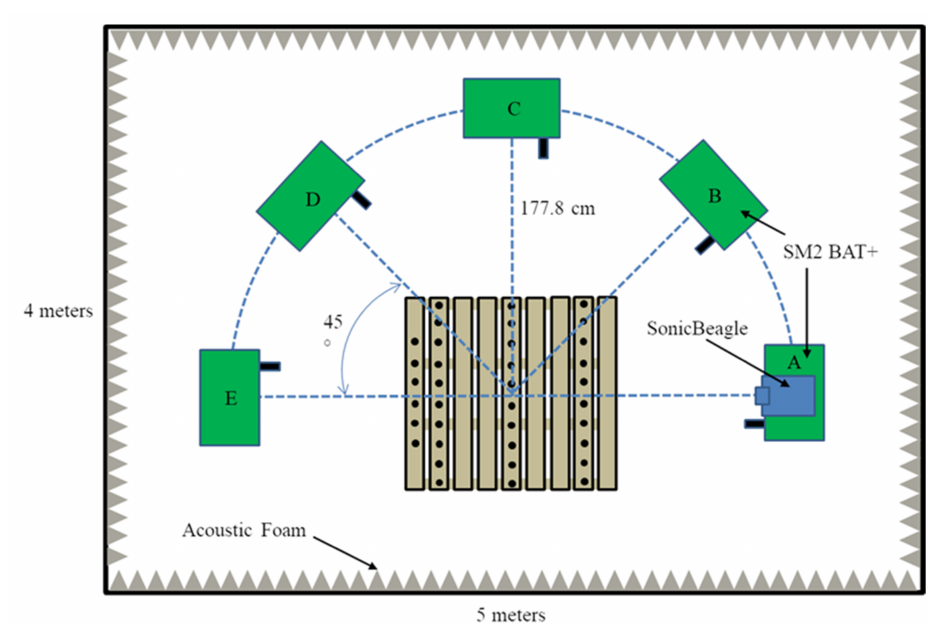
Figure 1. Diagram of the experimental setup in the anechoic chamber (4 m wide by 5 m long by 3 m high) where five SM2 BAT+ acoustic recorders (green rectangles) with SMX-U1 ultrasonic microphones (black rectangles; Wildlife Acoustics, Maynard, MA, USA) were arranged in a semicircle with radius 177.8 cm around a 107 cm × 121.9 cm wood pallet base with holes and mounting brackets designed to hold combinations of wooden dowels and landscape timbers to model varying levels of clutter. Note that the figure is not to scale and the center pallet is enlarged to show the 0–36–0 condition (see Table 1 for more details) as an example (Blacksburg, VA, USA,